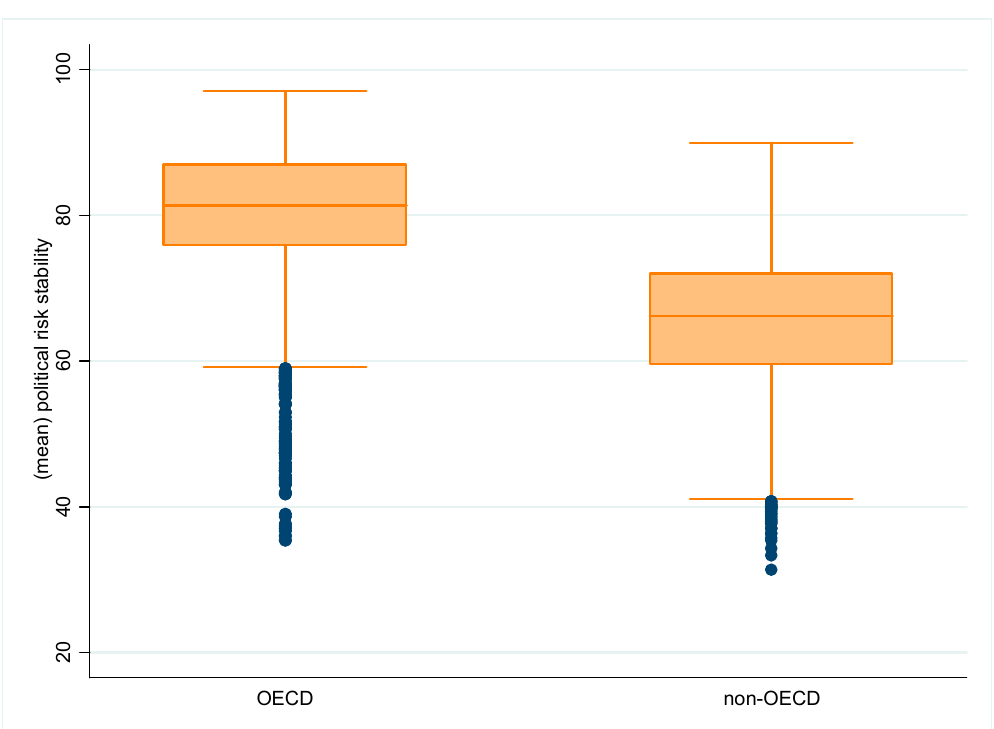
Figure A3. Box-plot: political stability (OECD vs. non-OECD countries).